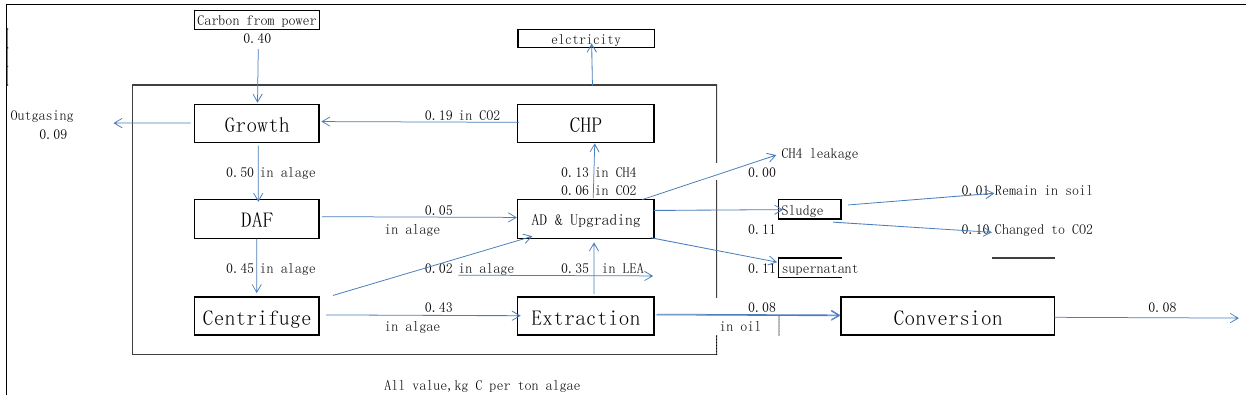
Figure 4. Carbon flows of the algae